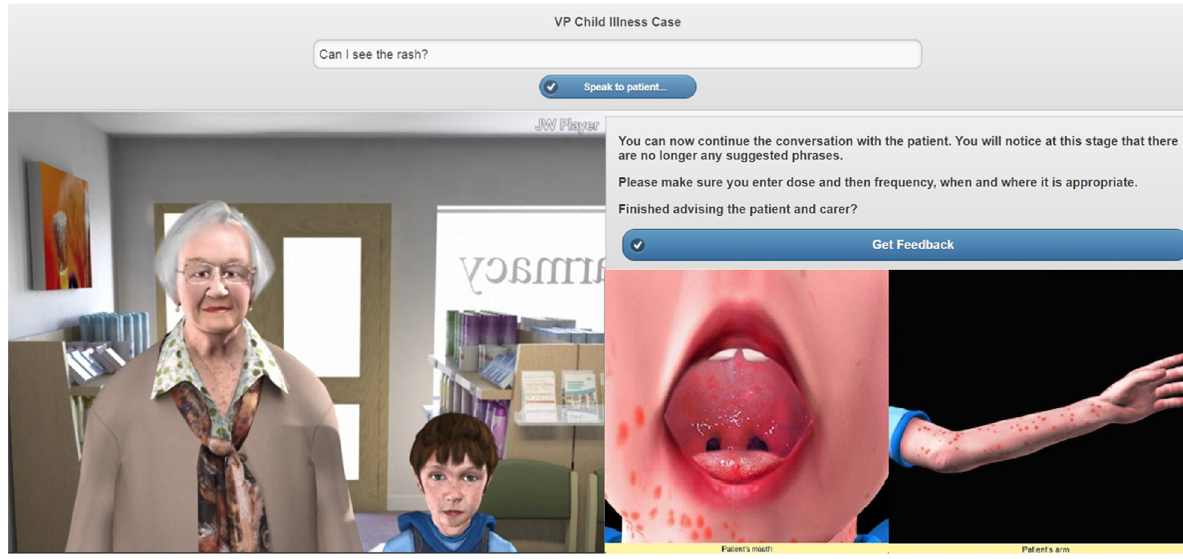
Fig 3. Screenshot of the childhood illness VP